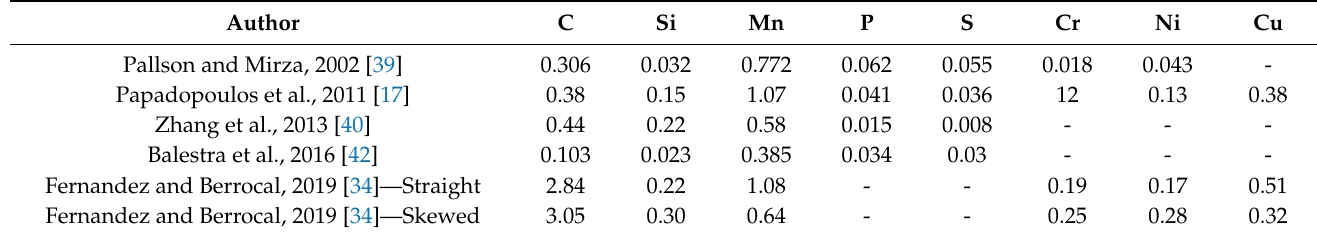
Table 3. Chemical composition of naturally corroded reinforcements (% of